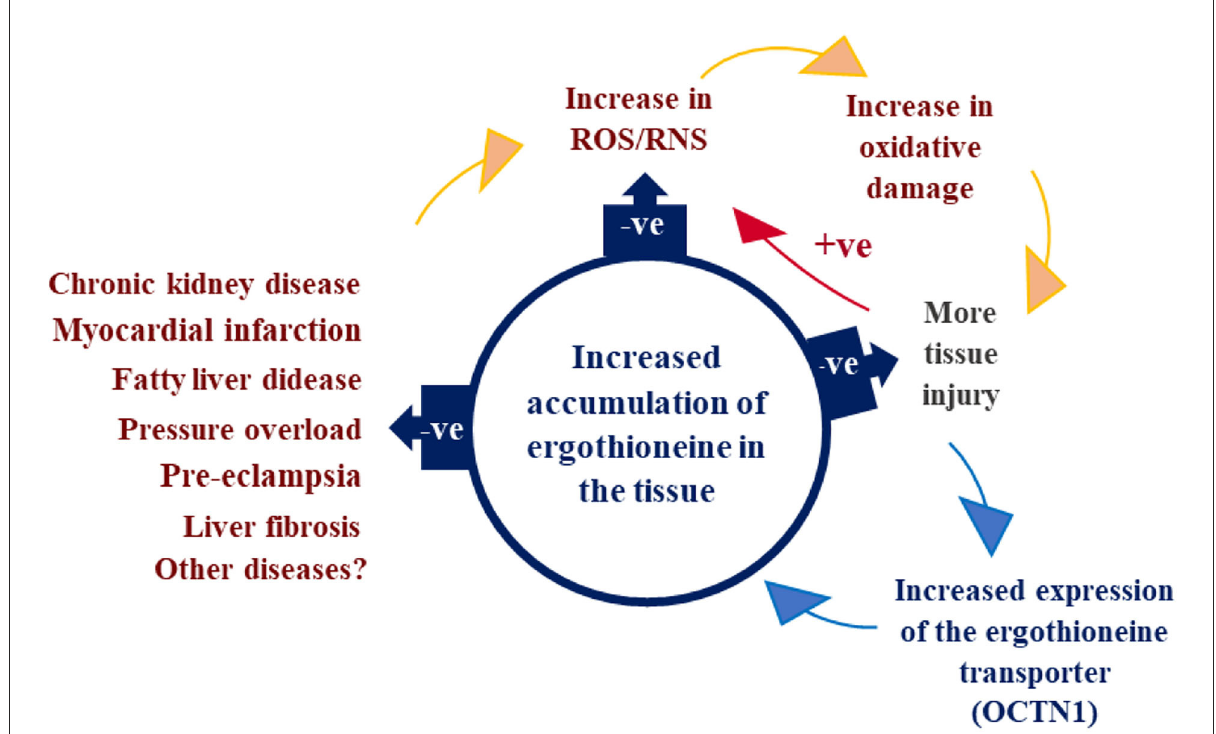
FIGURE6 Ergothioneine, a potent intra-mitochondrial antioxidant. A diet-derived antioxidant with therapeutic potential, approved by EFSA and FDA, referred to as a “longevity